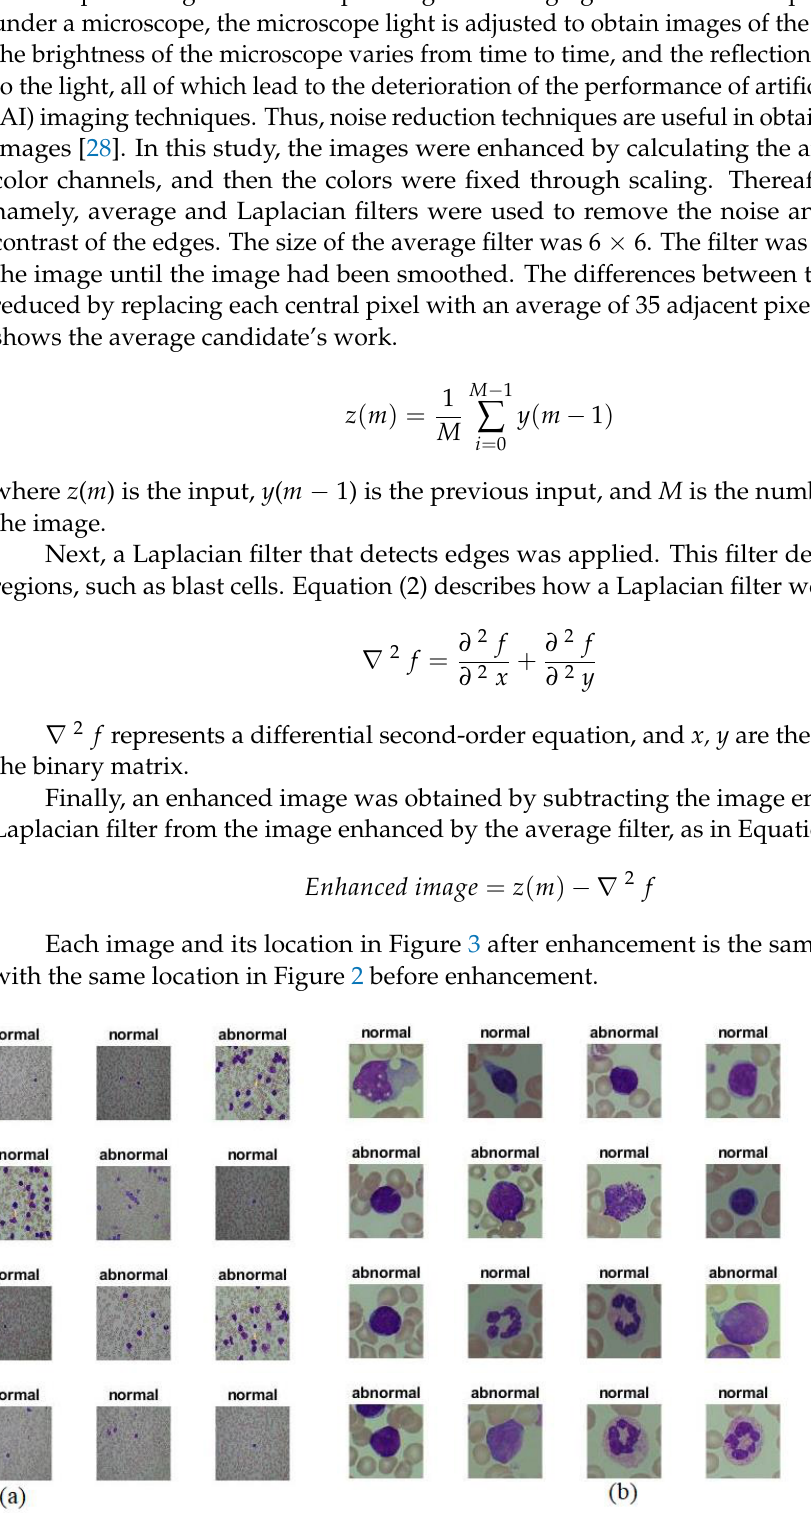
Figure 3. Samples from the ( a ) ALL-IDB1 and ( b ) ALL-IDB2 datasets after enhancement.